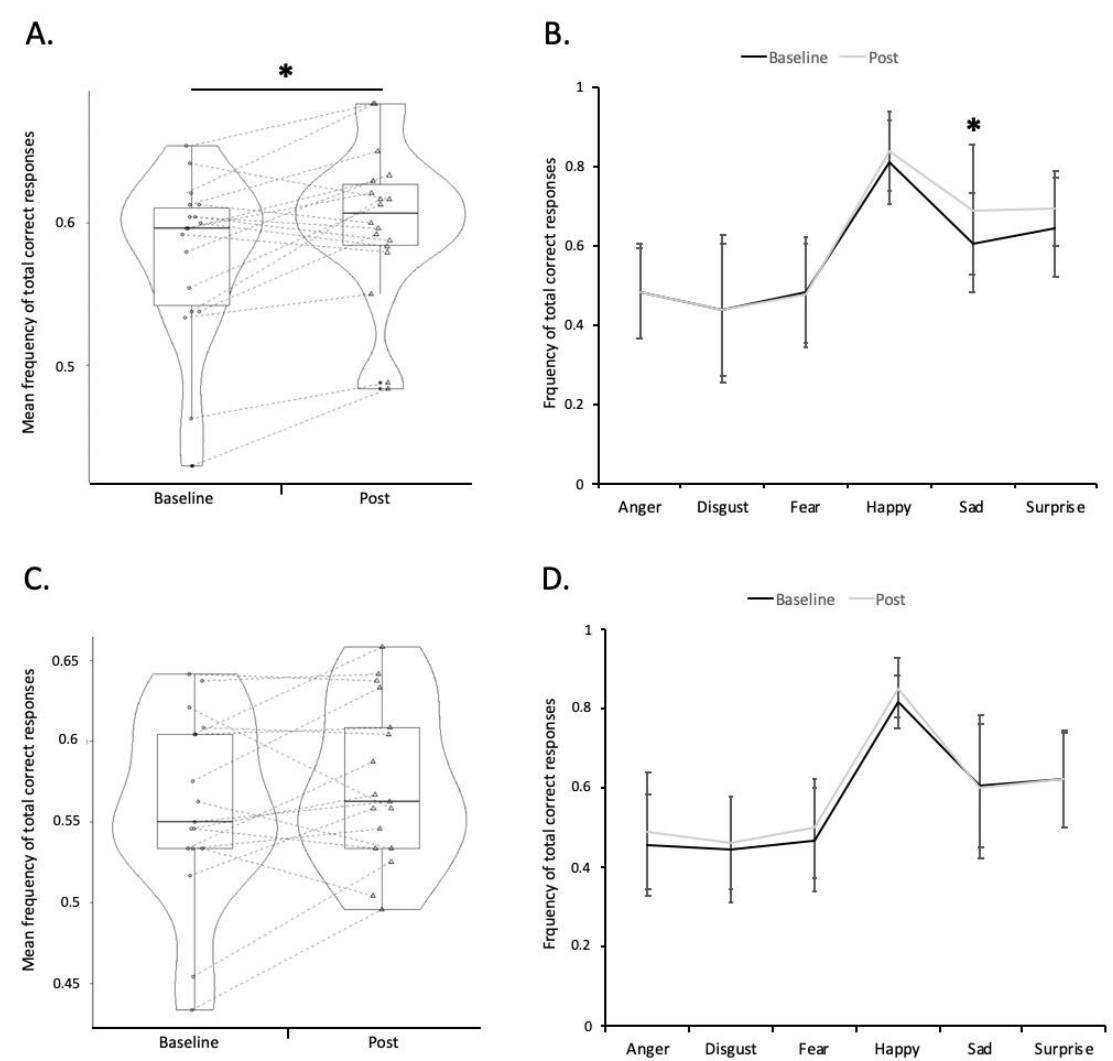
Figure 2. Changes in mean correct recognition of facial emotion expression following active (panel A) or sham tDCS (panel B). The repeated-measures ANOVA on recognition accuracy (measured as the frequency of correct responses) revealed a trend toward significance for the emotion*session*group interaction (F (5,165) = 2.231; η 2 = 0.062; p = 0.05). ( A ) significant overall facial emotion recognition (FER) improvement following active tDCS (ANOVA emotion*session, p = 0.04); ( B ) significant improvement of sad faces recognition after active tDCS (post hoc t-test with Holm’s *: p -value < 0.05); mean frequency of total correct responses emotion by emotion ( ± standard deviation) at baseline (black) and post-tDCS (grey). ( C ) no significant effect of sham tDCS on overall FER performance: ( p = 0.08). ( D ) no significant effect of sham tDCS emotion by emotion.